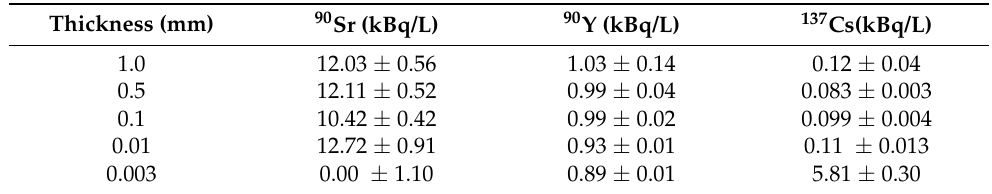
Table 5. The estimate of 90 Sr , 90 Y and 137 Cs activity from a realistic groundwater borehole using a 3 µm GaAs